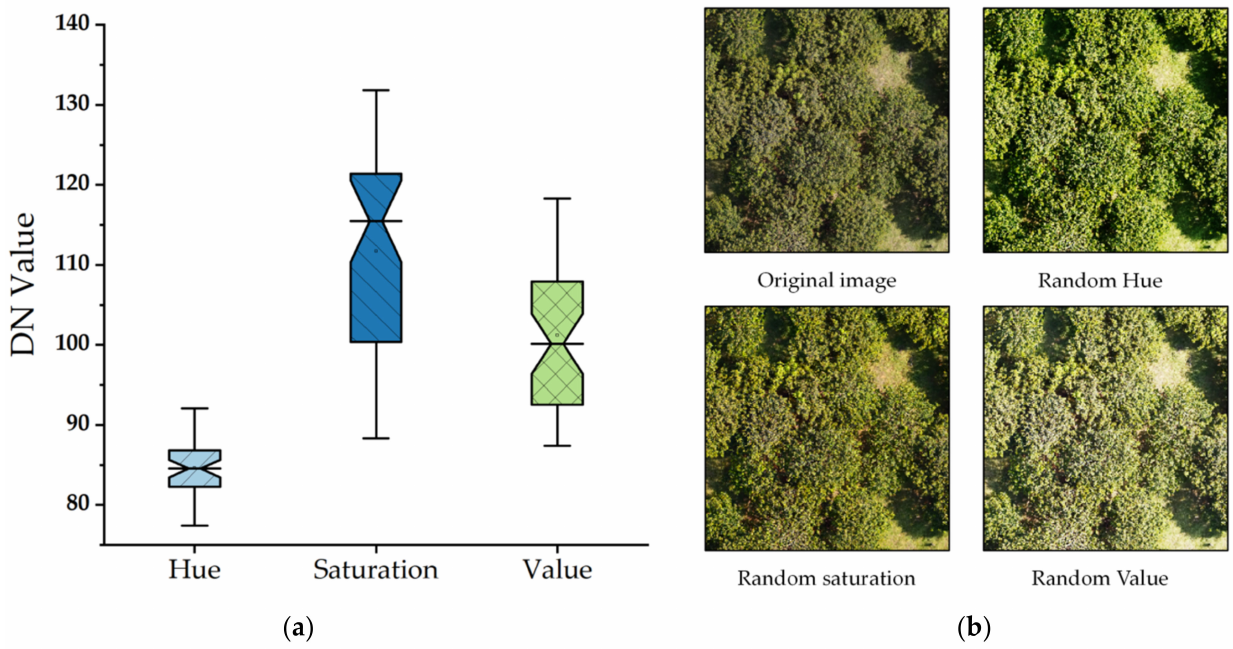
Figure 5. Spectral augmentation: ( a ) HSV boxplot; ( b ) spectral